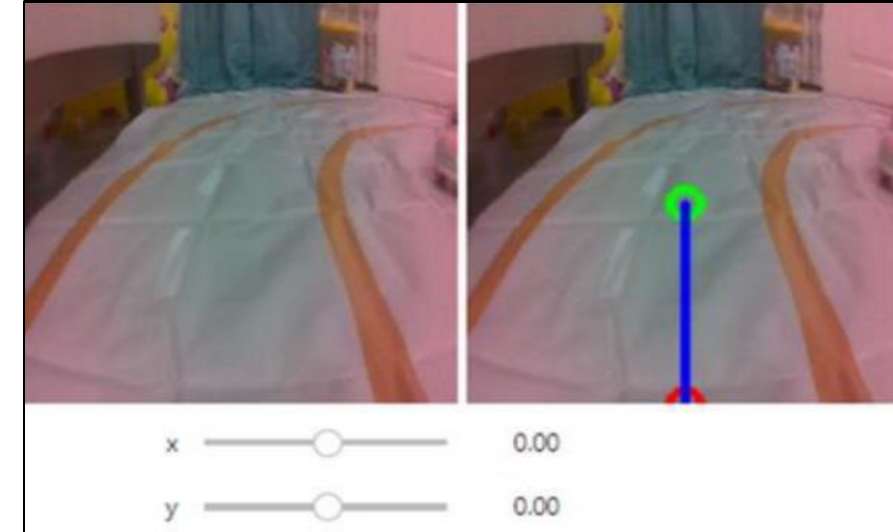
Fig. 6. Database Acquisition.